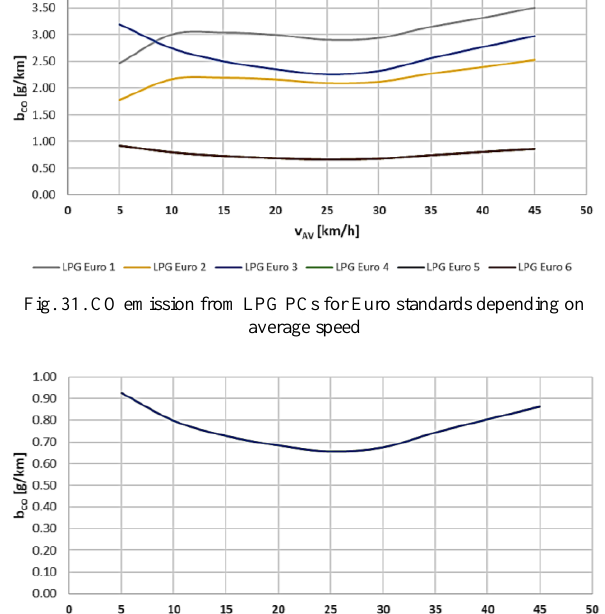
NMVOC emissions on the average speed for PCs segments.